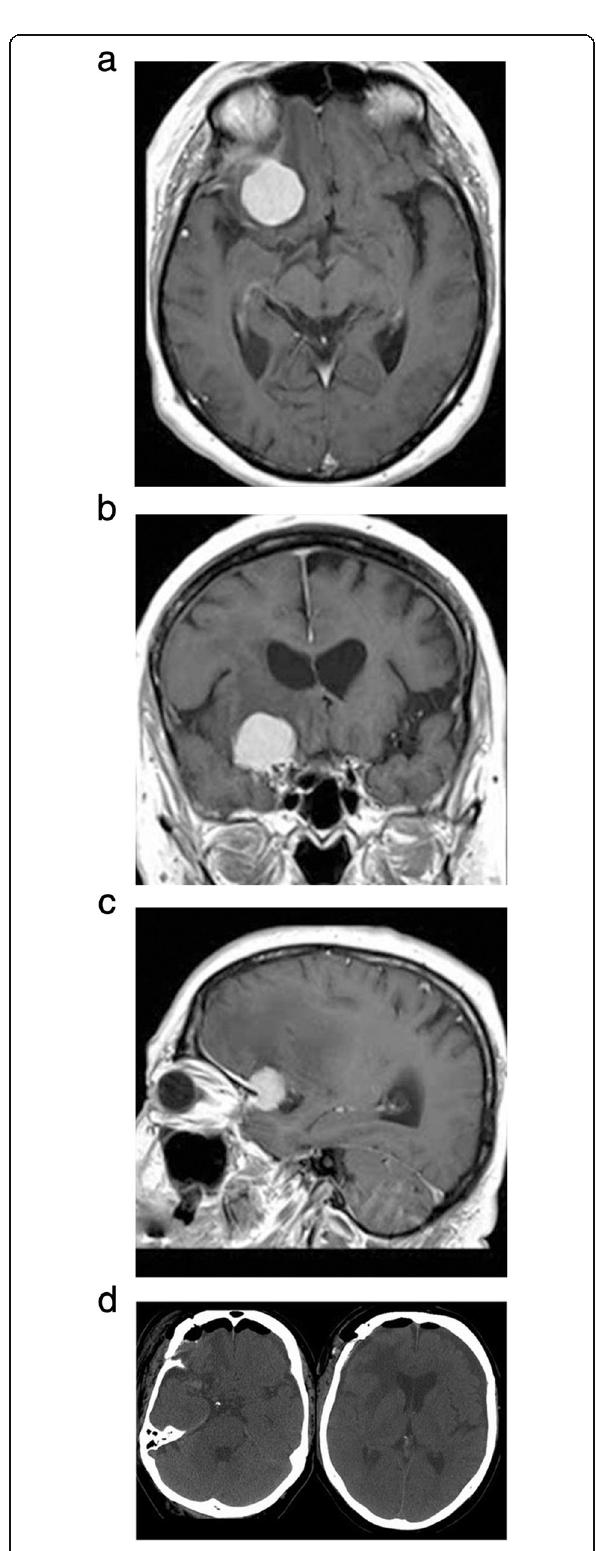
Fig. 3 A case of clinoidal meningioma successfully operated on through right-side lateral supraorbital approach. Preoperative axial ( a ), coronal ( b ), and sagittal ( c ) MRI views show clinoidal meningioma on the right side. Postoperative CT axial view ( d ) shows complete removal of the